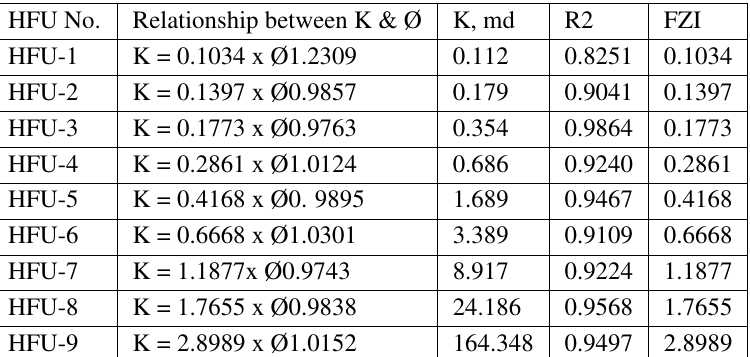
Table 1. Upper Bahariya reservoir hydraulic flow units